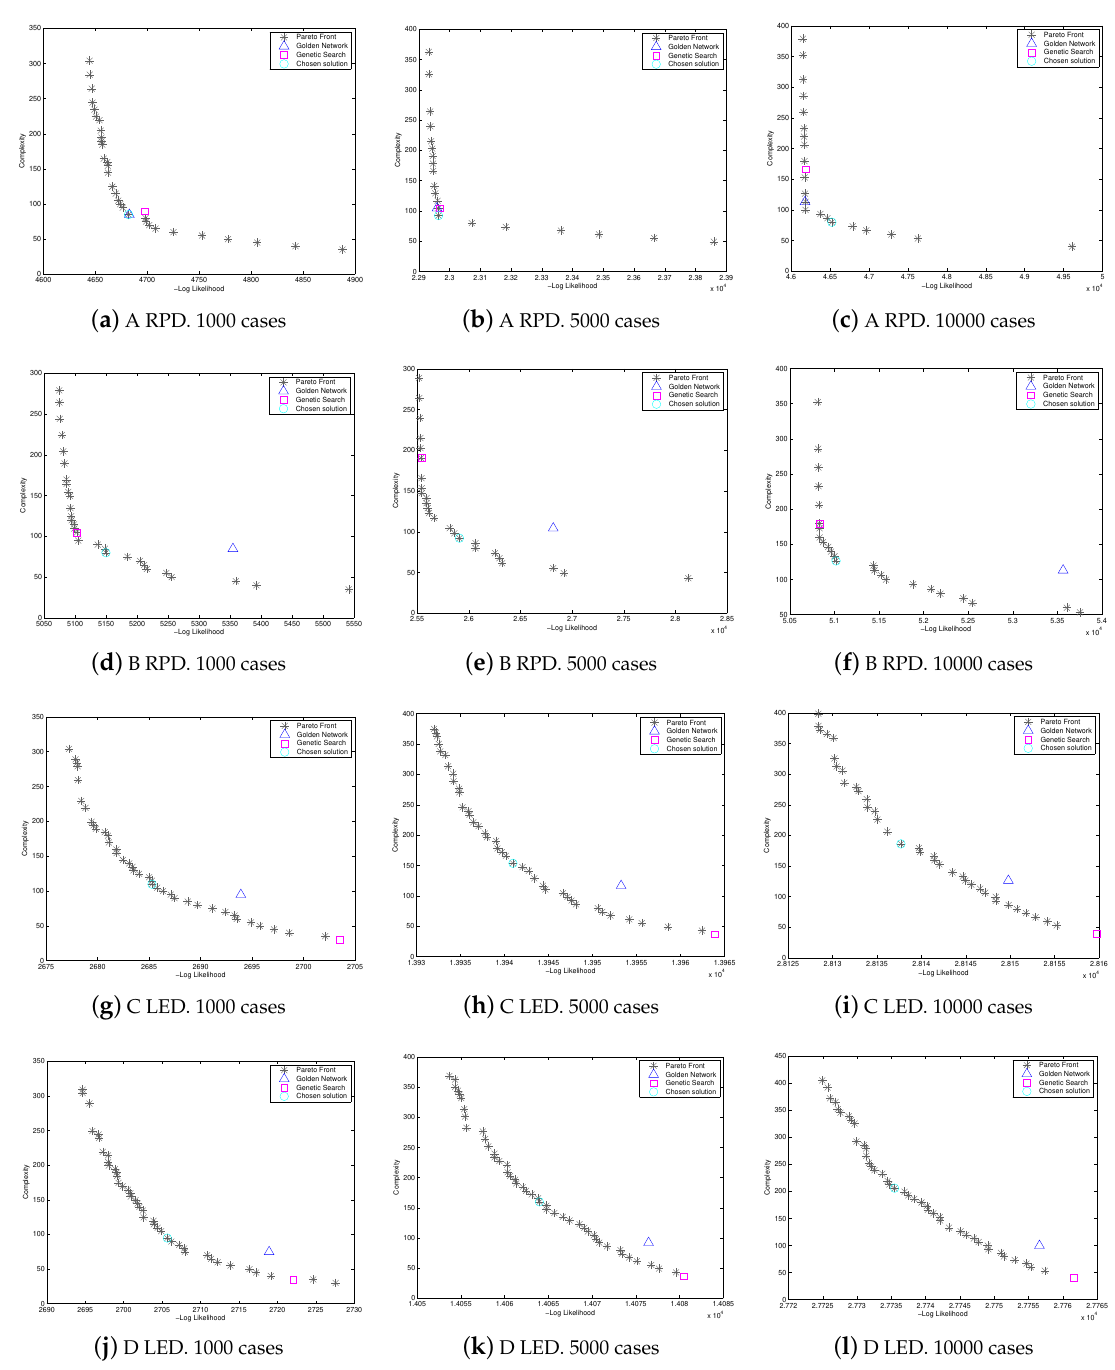
Figure 5. Accumulated Pareto front of the twelve first databases with 6-nodes, random probability distribution (RPD) and low-entropy probability distribution (LED). Gray stars—the accumulated front obtained by ten runs of NS2BN. Blue triangle—the golden-standard network. Pink square—the GABN solution and then green circle—the chosen solution from the NS2BN Pareto